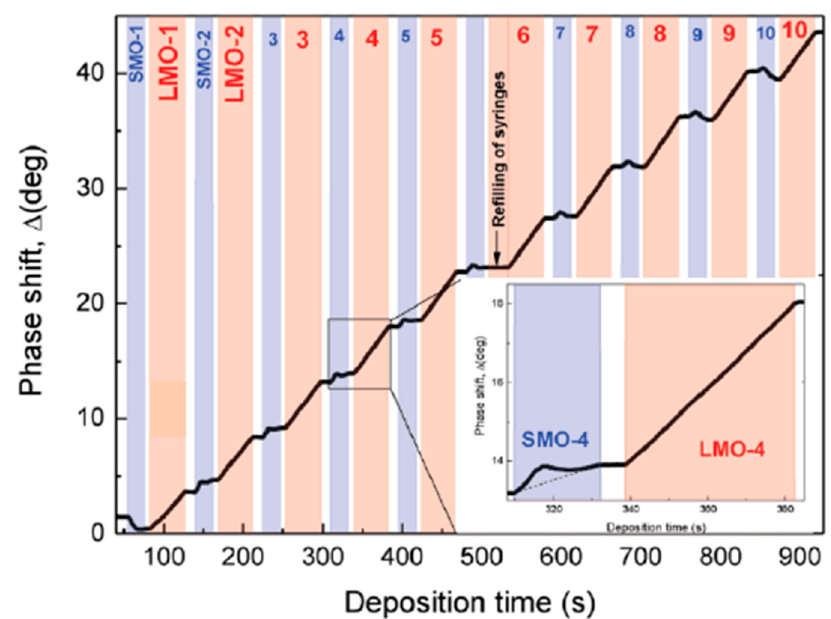
Figure 11. Ellipsometric ∆ ( t ) curve measured during deposition of an [( LMO 15 / SMO 5 )] 10 . The “blue”- and “red”-colored time intervals depict the SrMnO 3 (SMO) and LaMnO 3 ( LMO ) precursor pulses, respectively. During the delay time (“white”) between precursor pulses the ∆ ( t ) does not change, indicating constant optical properties of the already grown layers. A zoomed view on the 4th (SMO / LMO) bilayer in the inset shows a nonmonotonous ∆ ( t ) behavior during the SMO growth and a linear increase in ∆ by the LMO deposition. “Reprinted figure from [34] under permission licensed by John Wiley and Sons (Nr. 4654230253827)”.